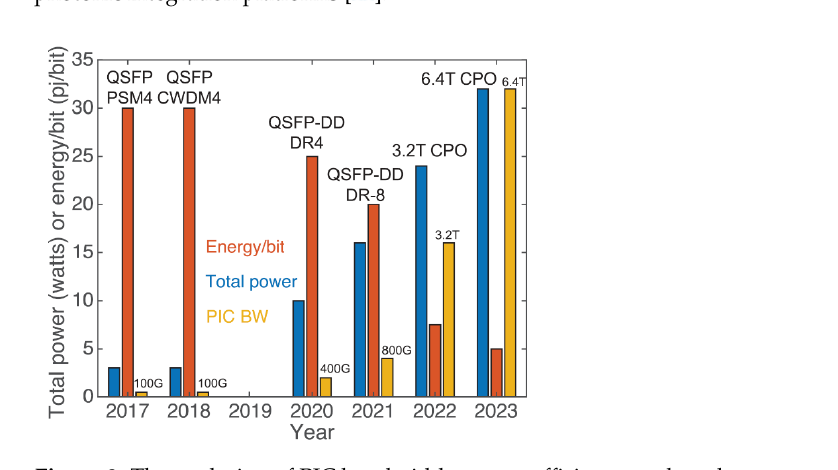
Figure 2. The number of photonic components integrated on a single waveguide over time for three photonic integration platforms [22].